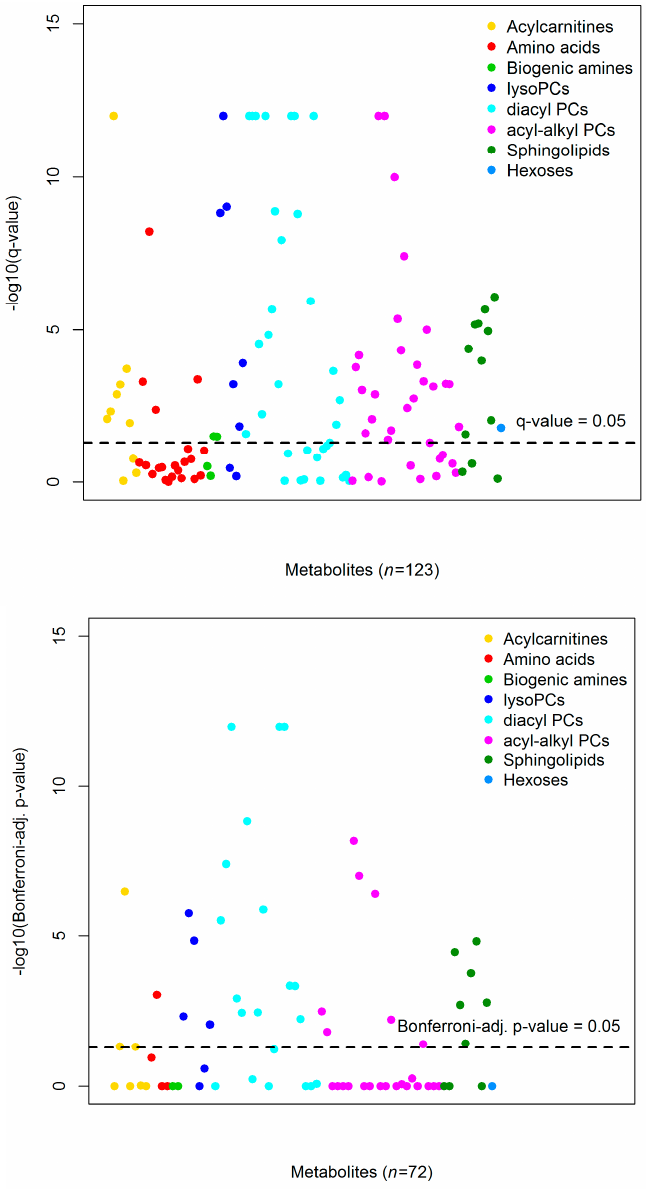
Figure 2. Manhattan plots showing –log 10 of FDR q- values and Bonferroni-adjusted p- values of associations of alcohol intake with metabolites in the ( a ) discovery (false discovery rate method; n = 1983) and ( b ) replication analysis (Bonferroni correction; n = 991), respectively. Footnote: Analyzed with multivariable linear regression analyses analyzing associations of alcohol consumption (ln-transformed alcohol intake + 1) as main independent variable and as dependent variables the residuals obtained from linear mixed models with Z-standardized ln-transformed metabolite concentrations as dependent variables, sex as independent variable, and random intercepts for analytical batches nested within studies. Adjusted for: sex; age (y; continuous), body mass index (kg/m 2 ; continuous), self-reported physical activity levels (Cambridge physical activity index [23]: inactive, moderately inactive, moderately active, active, unknown), fasting status ( ≥ 6 h, 3–5.9 h, <3 h, unknown), meat intake (g/day; continuous), fish intake (g/day; continuous), energy intake (kcal/day; continuous), country, and smoking status (current, former, never, unknown). The discovery and replication set were taken as random samples without replacement of 66.7% and 33.3% of the total dataset, respectively. Q-values/Bonferroni-adjusted p- values <1.0 × 10 − 12 (number of decimals above reporting limits of STATA and thus not provided) were set to 1.0 × 10 − 12 .